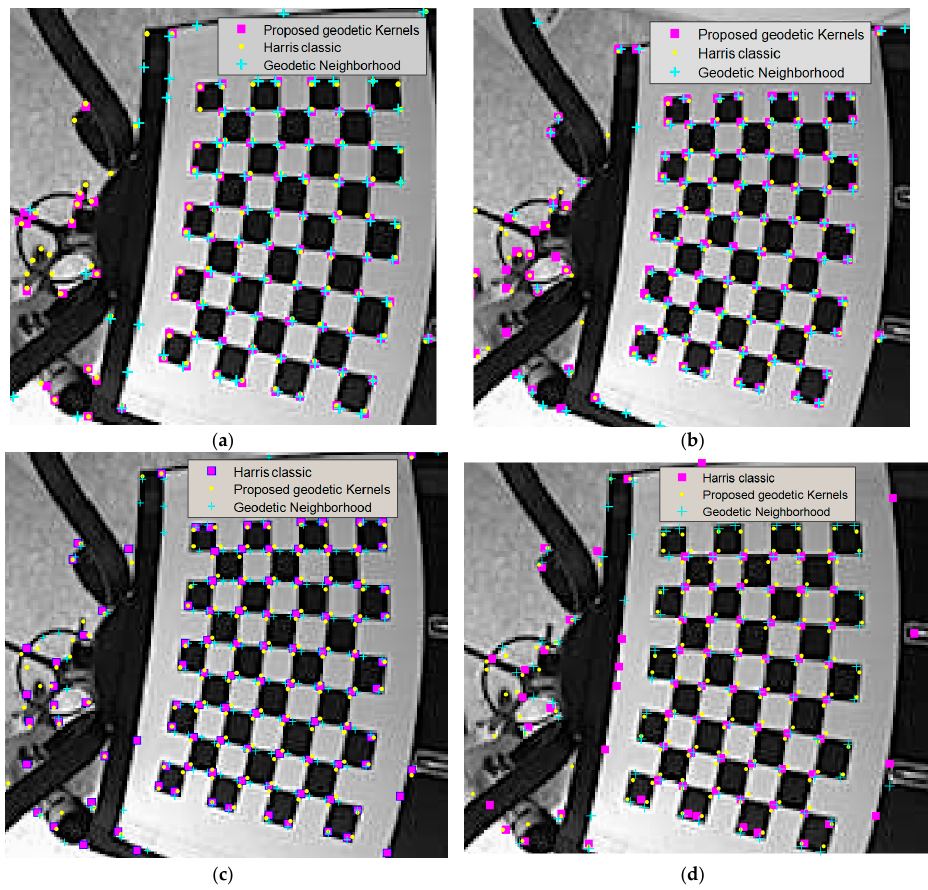
Figure 15. The chessboard area containing 80 corners, with detected corners form the three methods, considering only the 250 strongest responses. ( a ) 5 × 5 kernels, ( b ) 9 × 9 kernels, ( c ) 13 × 13 kernels and ( d ) 17 × 17 kernels. Table 1. Quantitative evaluation, in terms of corner detection, of the proposed geodetic kernel definition, the geodetic neighborhood definition in [22] and classic Harris-based corner detection. The